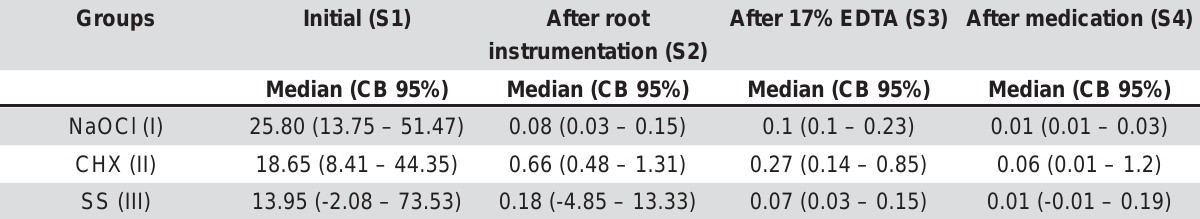
Table 1- Distribution of the median values of endotoxins (EU/mL) found in primarily infected root canals at all different sampling times